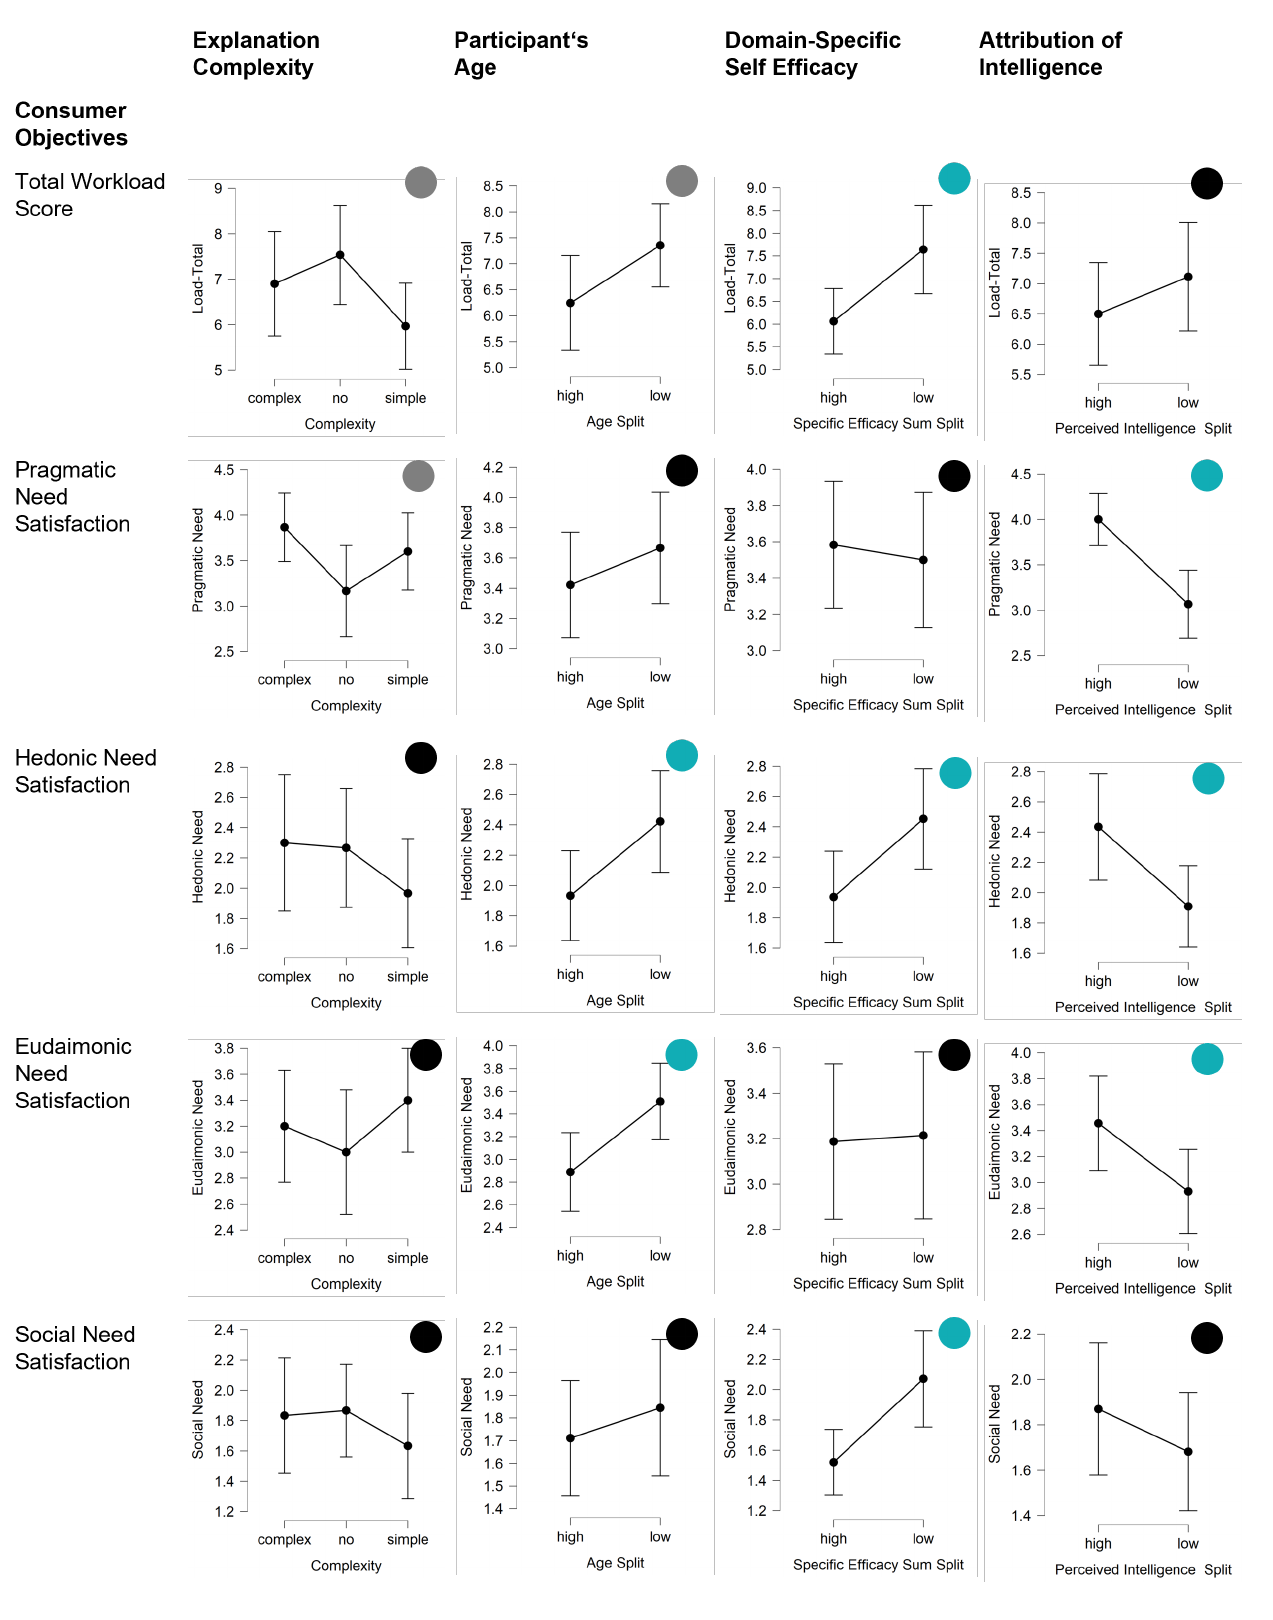
Figure 8. Results regarding consumer explanation objectives (workload and need satisfaction). The first column shows the impact of explanation complexity (complex, no, simple). The other columns show the influence of the human dimensions (age, domain-specific self-efficacy, and mind